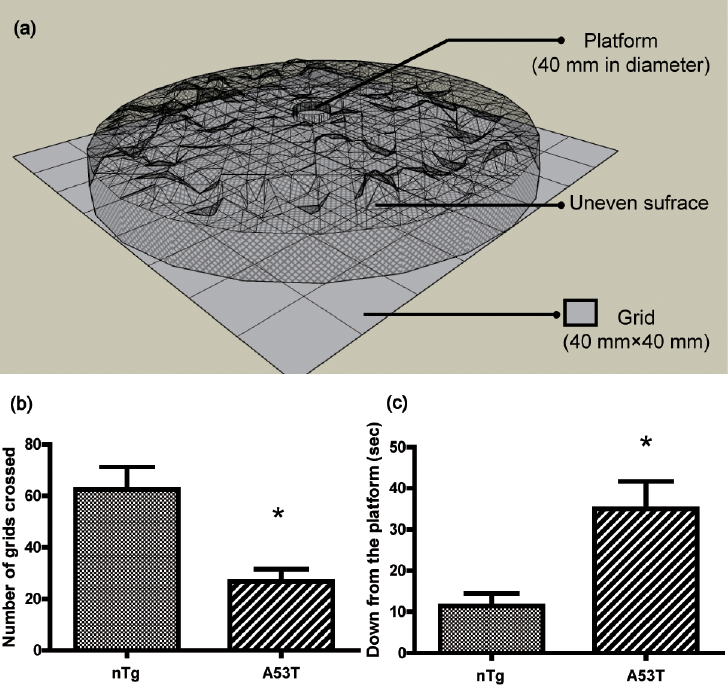
Figure 1. Motor behaviors of A53T α -synuclein Tg mice (10–14 months old) and age-matched nTg littermates were evaluated a using modified open field test. ( a ) 3-D model for modified open-field test apparatus. The data (mean ± SEM) show the number of grids crossed ( b ) and the time to get down from the platform ( c ) in a 6 min period in an open field (nTg, n = 8; A53T, n = 12). * p <0.05 compared to nTg. anti- α -synuclein antibody (Cell Signaling Technology, #2647, 1:50). Immunostaining was visualized by